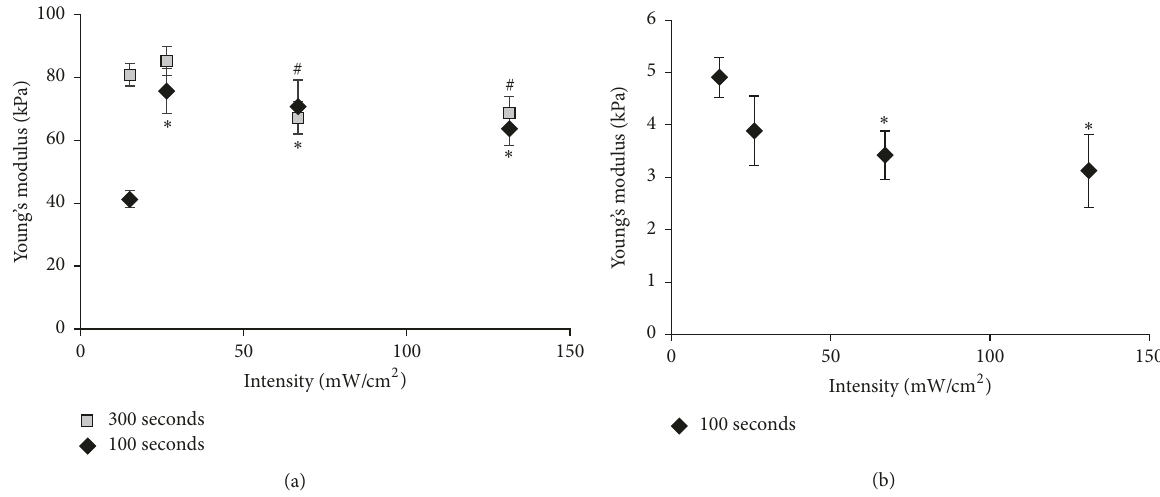
Figure 2: Young’s modulus as a function of UV light intensity for (a) A12-B.25 and (b) A8-B.10, PAA hydrogels. Asterisks and pound symbols designate significant differences from Young’s modulus for gels polymerized at 15mW/cm 2 ( 𝑝 < 0.05 , 𝑛 = 3